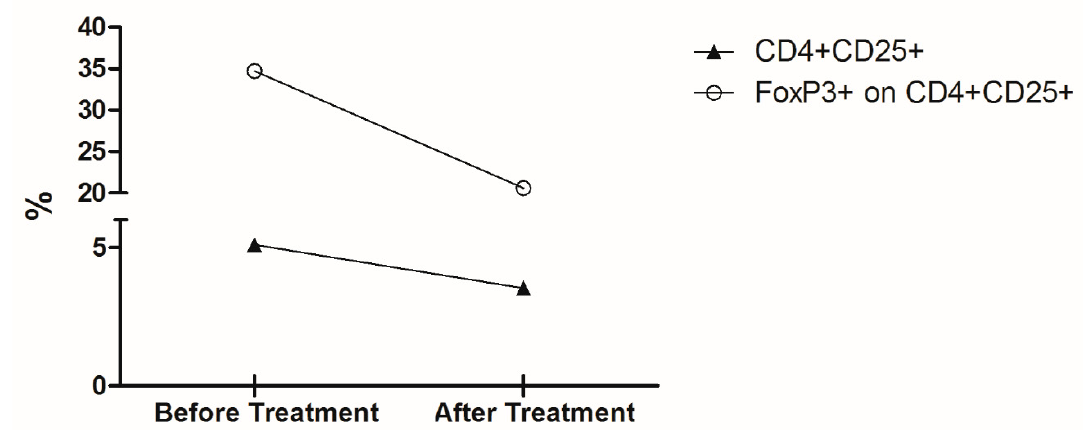
Figure 3. Percentage of circulating cells with T regulatory phenotype before and after treatment. Graph depicts the ex vivo percentage of CD4 + CD25 + T cells ( (cid:78) ) and the percentage of Foxp3 + cells on CD4 + CD25 + T cells subpopulation ( ) from the patient’s PBMC collected before and after treatment with meglumine antimoniate.